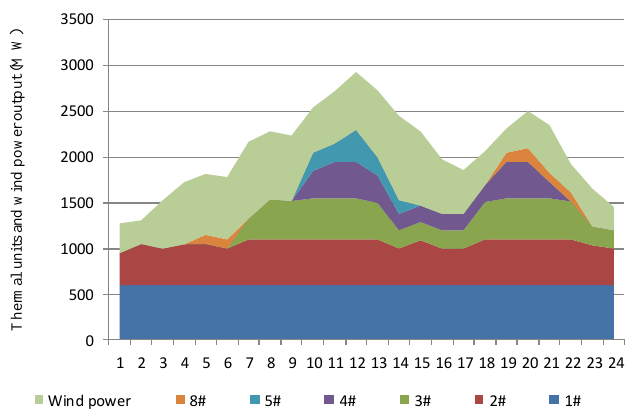
Figure 4. Thermal units and wind power output in Case